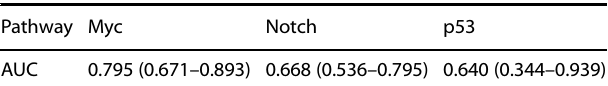
Table 6. AUC (with 95% CI) achieved by the models trained on the pathway activity derived from copy number alteration data of breast